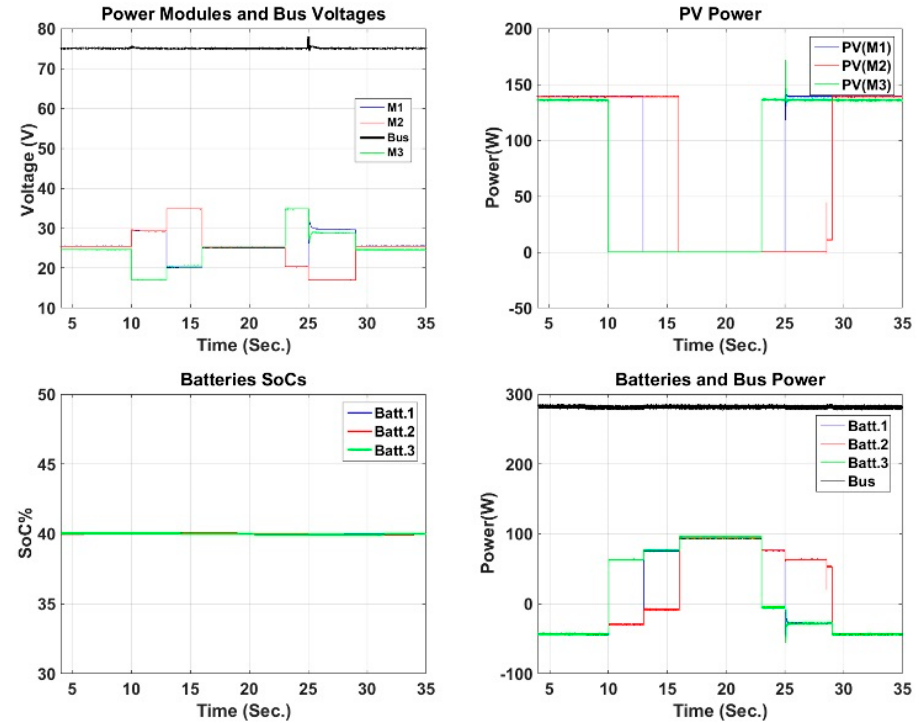
Figure 12. Bus voltage control under availability/unavailability of PV power.